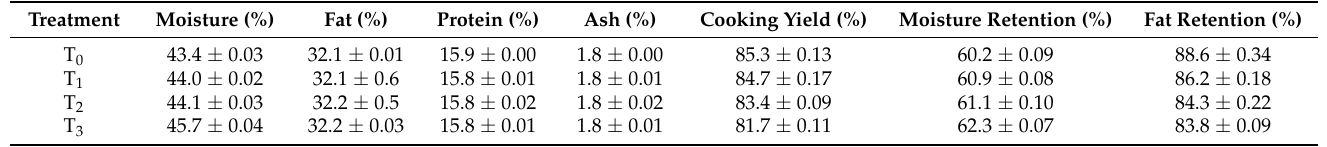
Table 6. Proximate composition and cooking properties of O. basilicum essential oil-supplemented nuggets.